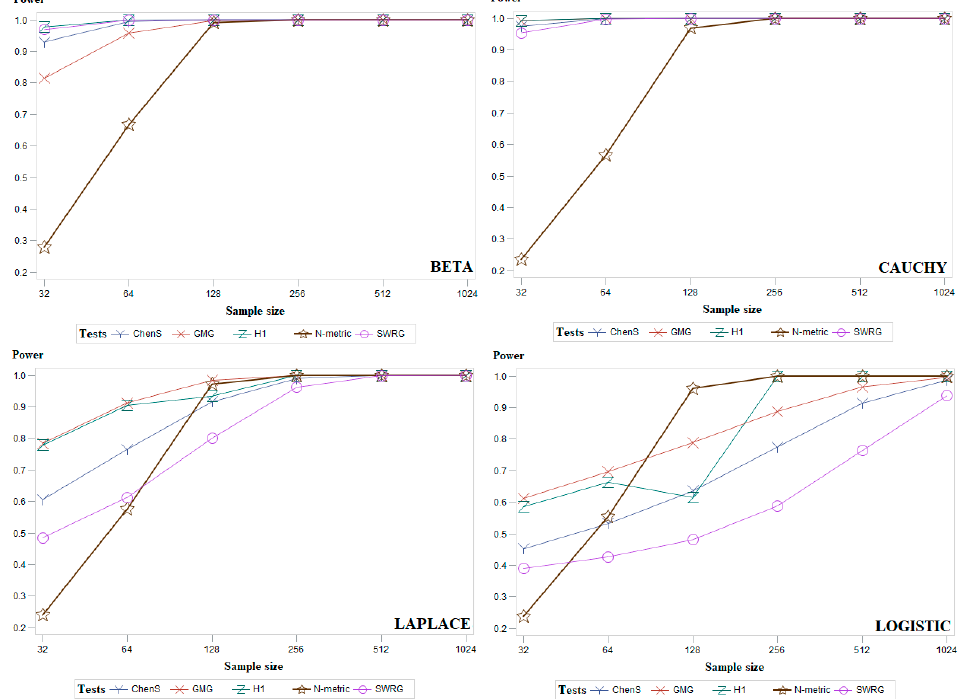
Figure A1. Average empirical power results, for all sample sizes, for the groups of symmetric distributions of five powerful goodness-of-fit